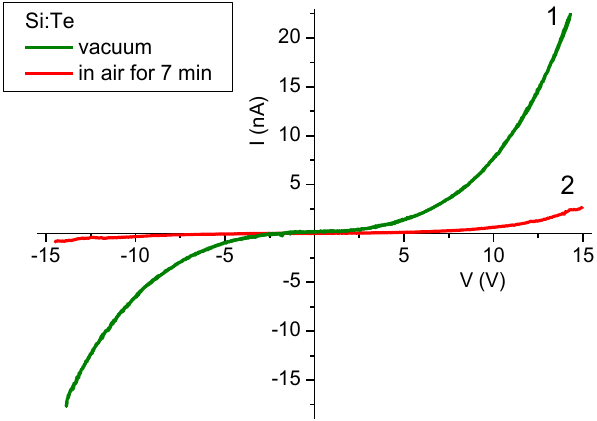
Figure 10. I–V characteristics of Si:Te film measured at room temperature: ( 1 ) in a vacuum; ( 2 ) after 7 min of contact with air.